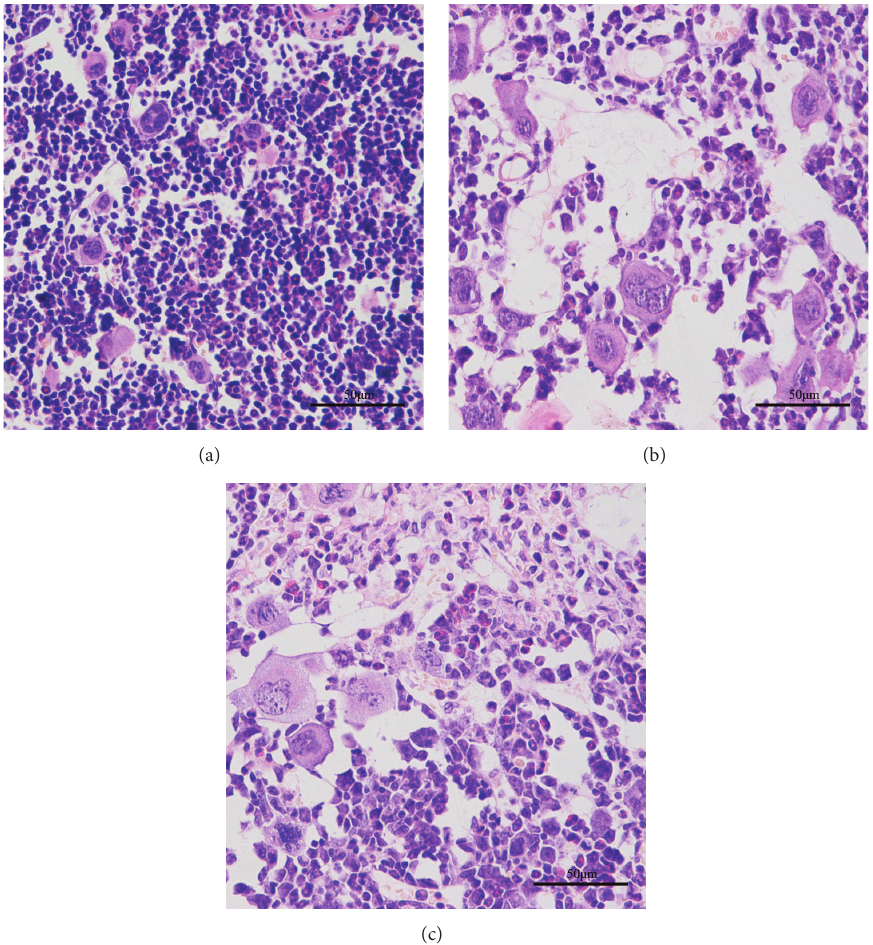
Figure 3: Mice bone marrow histopathology at day seven after placentas pooled cells treatment (400x). (a) Healthy normal controls; (b) model-only controls; (c) multiplacentas pooled cells transplanted mice.